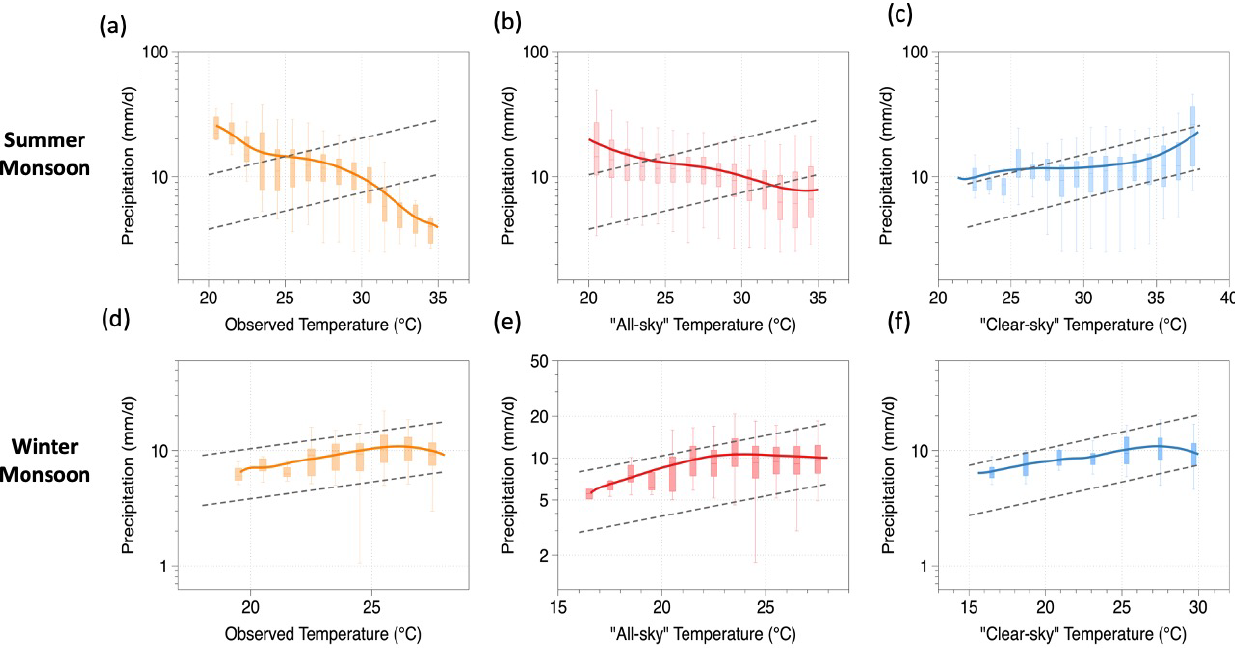
Figure C3. Extreme precipitation–temperature scaling during the summer monsoon (a–c) and winter monsoon (d–f) . Scaling curves are shown in yellow for observed temperatures (a, d) , in red for all-sky temperatures (b, e) and in blue for clear-sky temperatures (c, f) . Solid yellow/red/blue lines indicate the LOESS regression lines. Dotted grey lines indicate the Clausius–Clapeyron (CC) scaling rate. Note the logarithmic vertical axis. Dataset used is